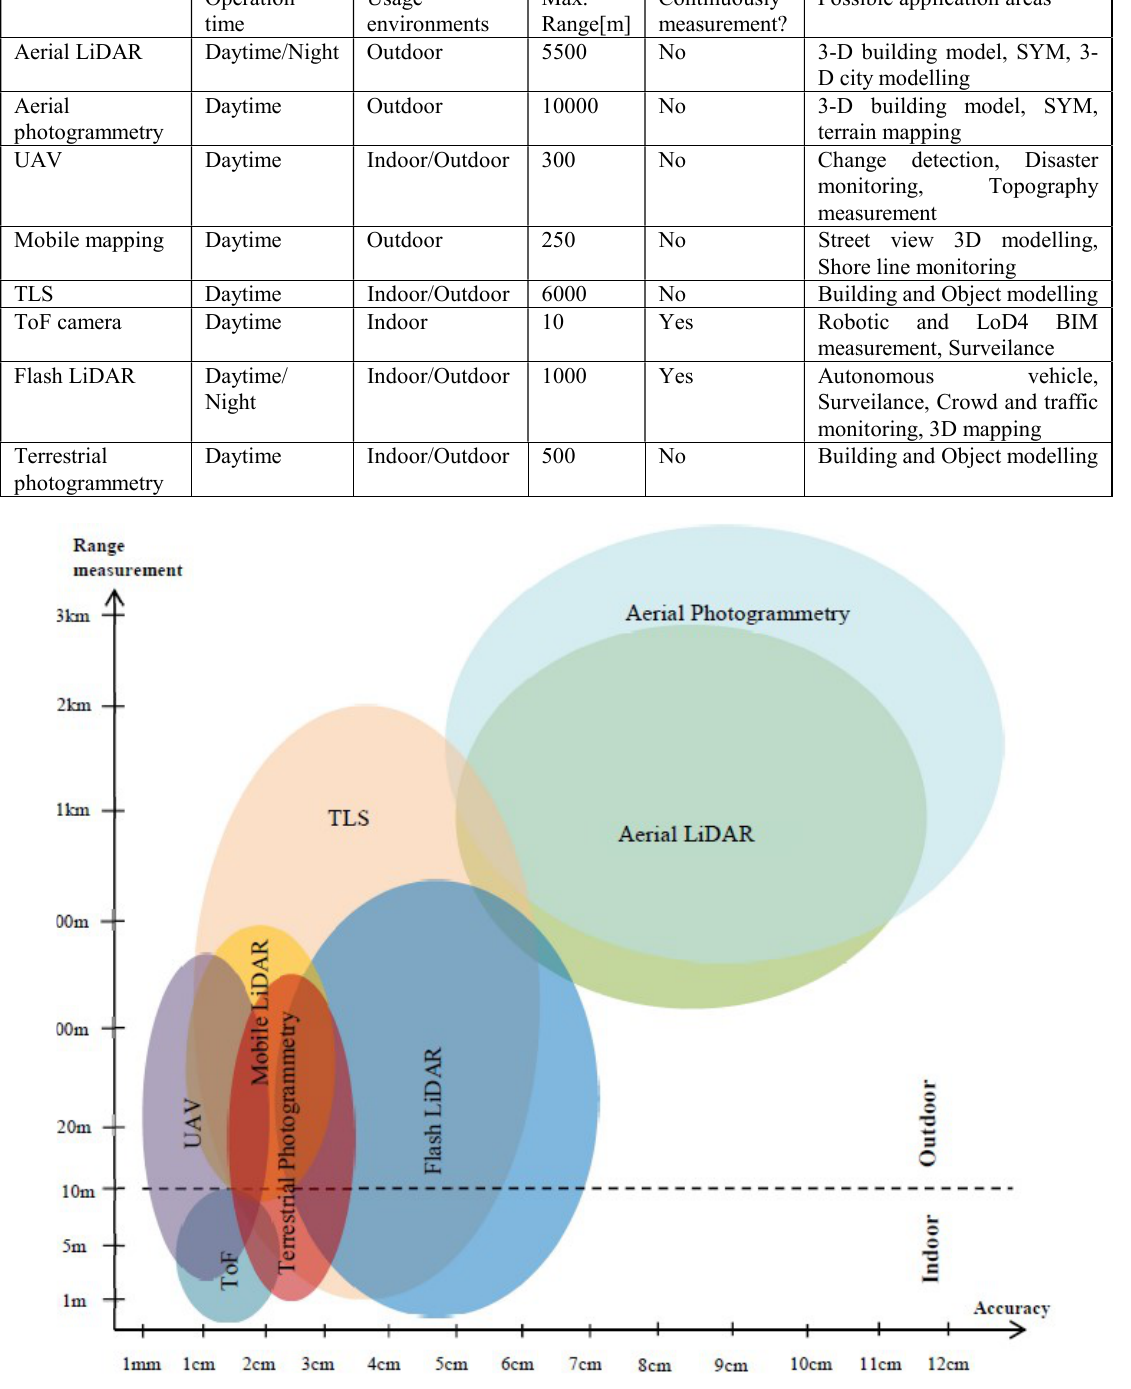
Figure 7. The specific characteristics of point cloud measurement techniques proposed for